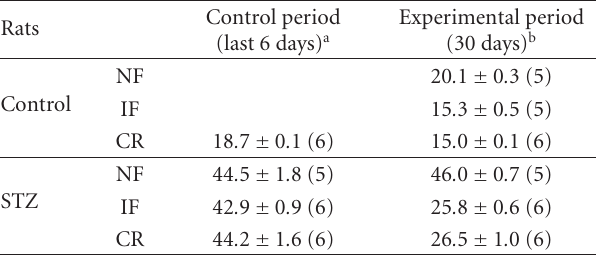
Figure 1: Comparison between the changes in body weight over the last 30 days experimental period in IF and CR control or streptozotocin rats. Mean values ( ± SEM) refer to 5-6 individual measurements. Table 1: Food intake (g/day per